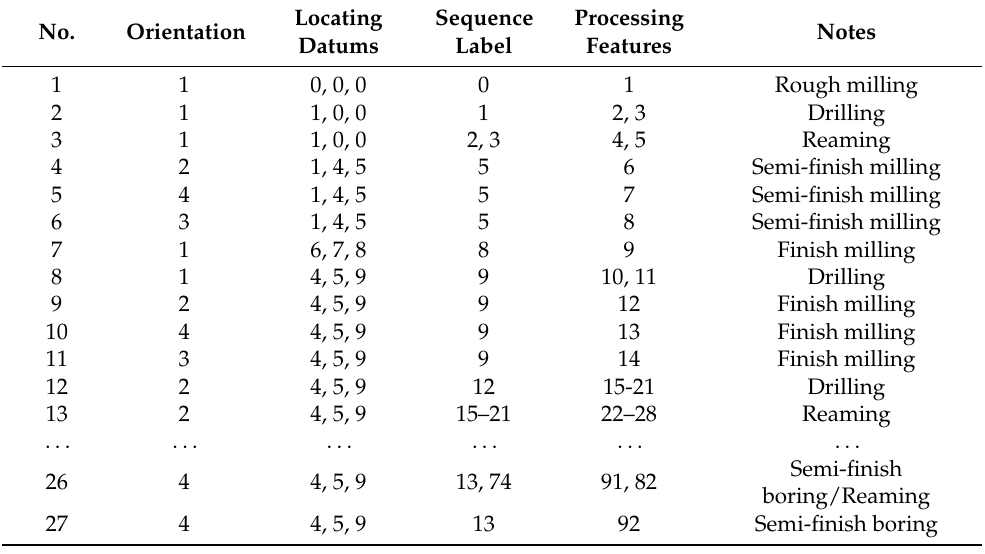
Table 3. Processing units of part